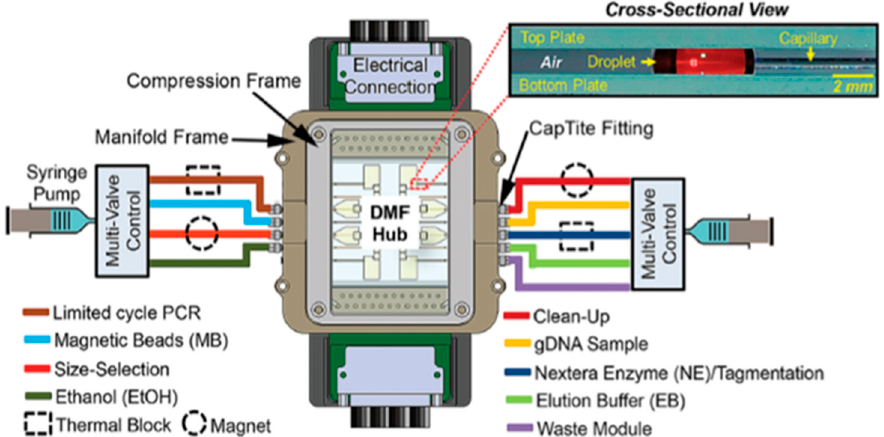
Figure 6. Schematic representation of the DMF platform proposed, evidencing the location of all the reagents required for DNA sequencing. The gap between plates was maintained at either 185 µm or 400 µm, according to the intended droplet volumes, and no filler medium was added. Adapted from original in reference [32].